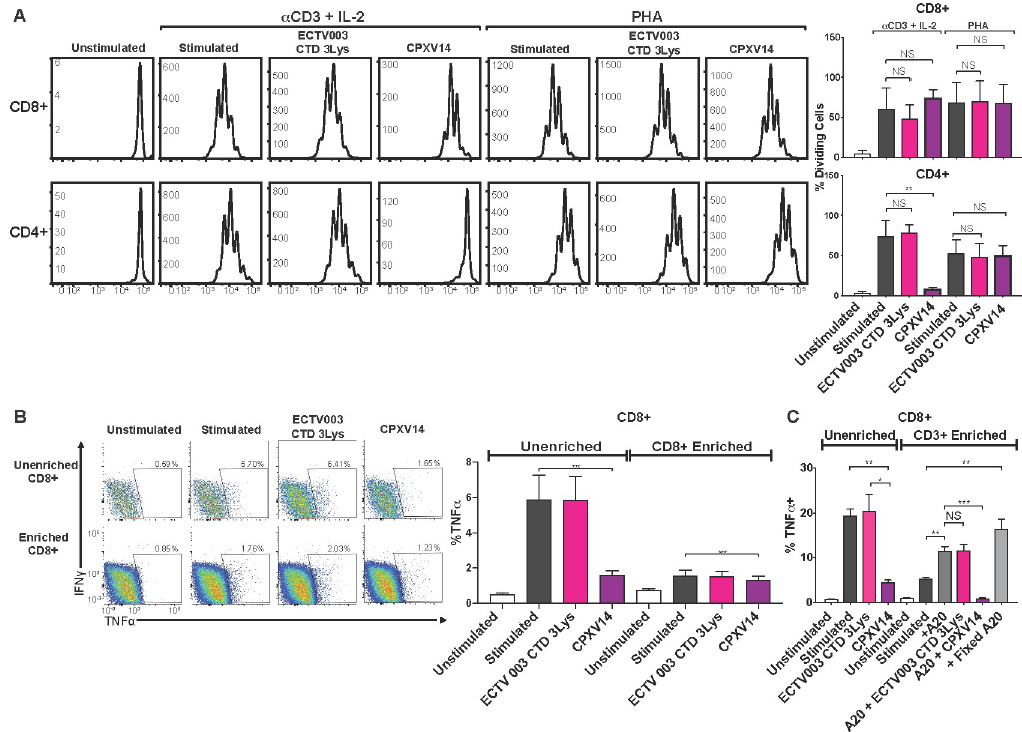
Fig 4. T cell inhibition by CPXV14 is limited to antibody stimulation and requires the presence of auxiliary cells. A) CPXV14 inhibits T cell proliferation when stimulated by α -CD3 + IL-2 but not by PHA. Splenocytes from BALB/cByJ mice were loaded with CFSE and stimulated with α -CD3 and recombinant murine IL-2 or PHA for 3 days in the presence or absence of the indicated recombinant proteins (100nM) followed by flow cytometry. Representative histograms collected from one animal (left) or average percentage (+SEM) of dividing cells from 5 mice (right) are shown. B) Reduced stimulation and lack of CPXV14 inhibition upon enrichment of CD8+ T cells. CD8+ T cells were enriched ( > 97% CD8+) or not from murine splenocytes and incubated with 100nM of CPXV14 or control protein (ECTV003 CTD-3Lys), and subsequently stimulated with plate-bound α -CD3 and α -CD28 followed by ICS. Left: Representative plots from one mouse. Right: Average frequencies of TNF α producing CD8+ T cells from 10 mice (2 experiments, n = 5 each) (+SEM). C) Stimulation and CPXV14 inhibition of enriched CD8+ T cells is restored in the presence of auxiliary cells. Splenocytes were either left unenriched or enriched to > 85% CD3+ cells. Where indicated, live or fixed A20 cells, a BALB/c mouse-derived B cell line, were added to CD8+ T cells at a ratio of 1:2 (A20:CD3+) in the presence or absence of the indicated poxviral proteins (100 nM). Average frequencies of TNF α producing CD8+ T cells are shown (n = 5, +SEM). P-values were calculated using paired two-tailed Student’s T test ( ��� p � 0.001, �� p � 0.01, � p � 0.05, NS = p >